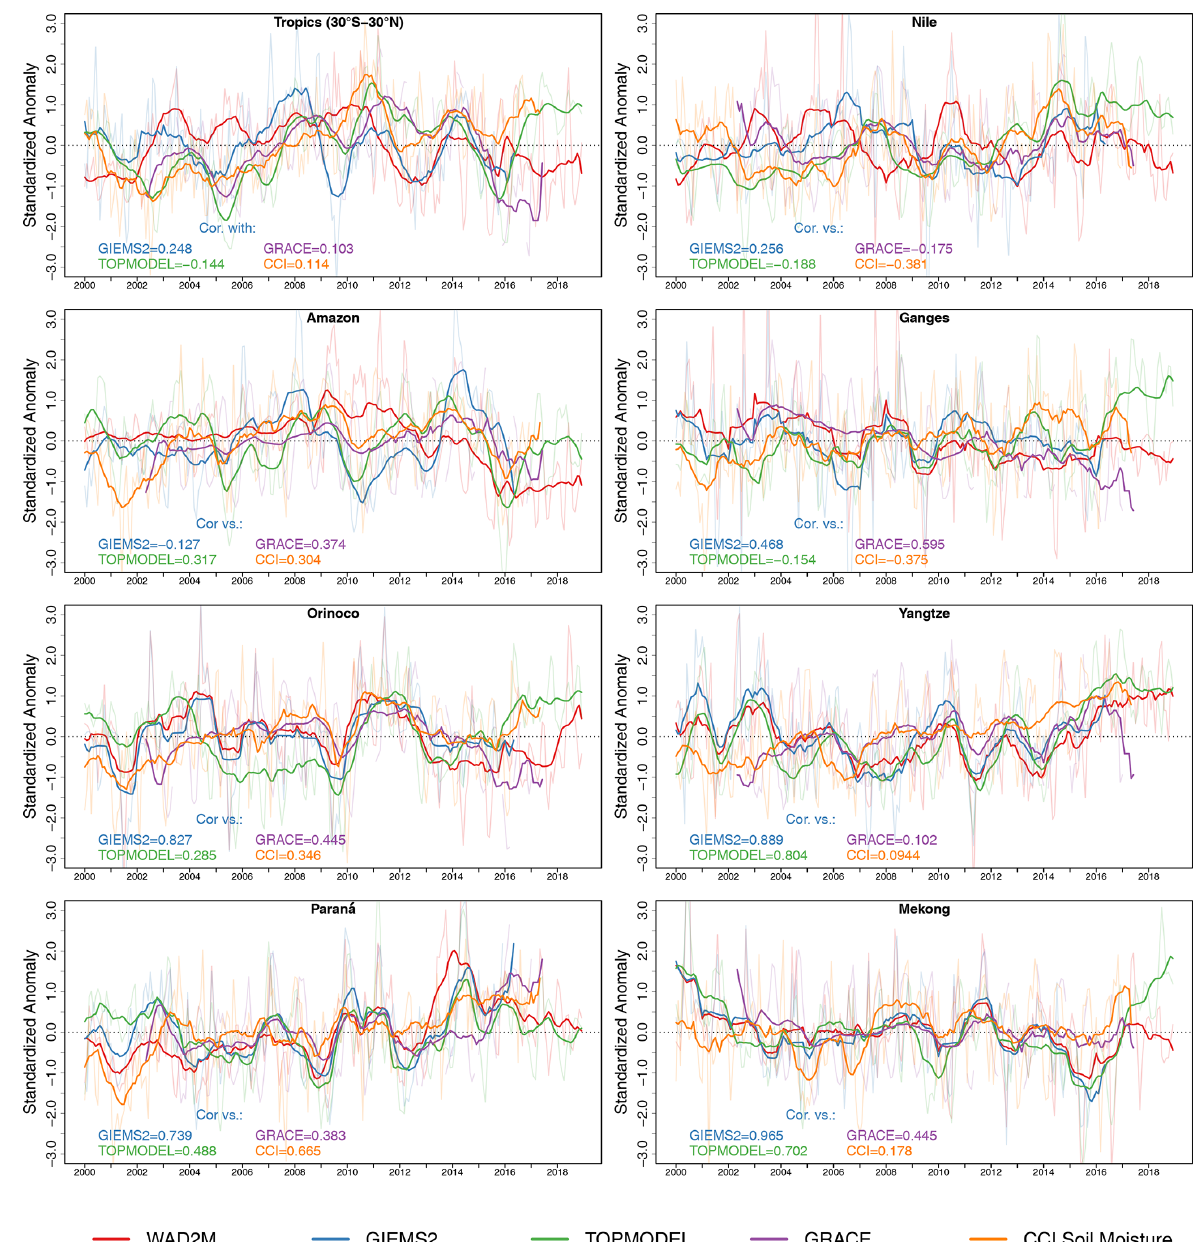
Figure 8. Temporal variations in wetland anomalies in WAD2M in comparison with terrestrial water products from multiple sources. Monthly mean anomaly was calculated as total wetland area within a watershed and was then standardized using a Z score. The shaded lines and the solid lines represent monthly anomalies (standardized value) and trends (12-month running mean of the anomalies). The water- shed boundaries are defined using the HydroBASINS dataset (Lehner and Grill, 2013). The correlations in the trend between WAD2M and other sources are